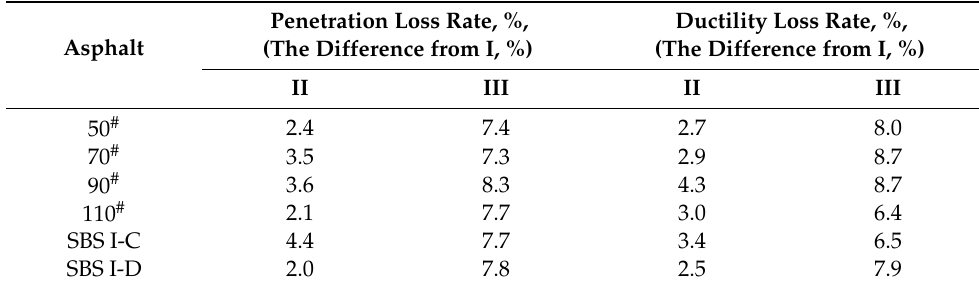
Table 6. The difference from zone I of penetration loss rate (the penetration loss rate and ductility loss rate of asphalt in UV climate zone II and III).